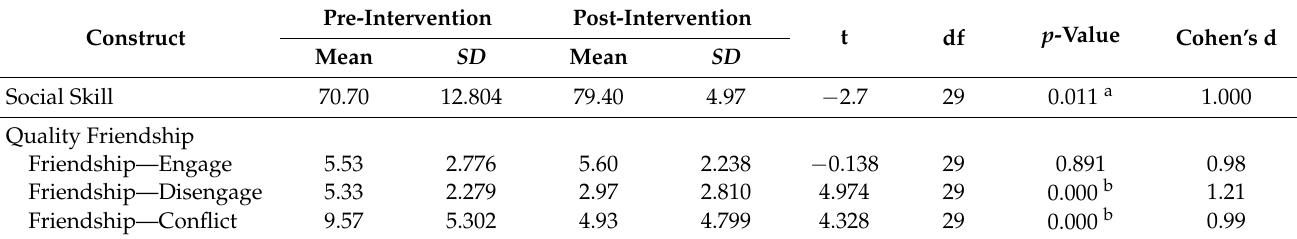
Table 4. Descriptive statistics and